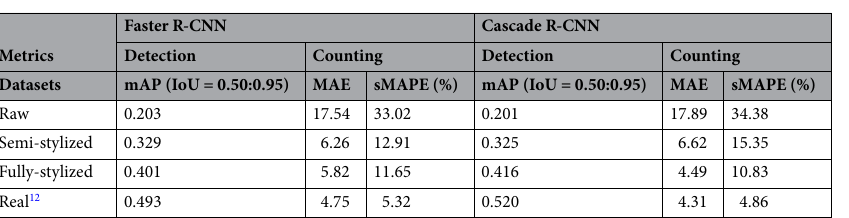
Table 2. Microbial colonies detection tested on real data for three different synthetic training datasets: raw , semi-stylized , and fully-stylized . For comparison, we also provide results for training on the real dataset 12 . We present results for Faster R-CNN and Cascade R-CNN detectors along with various metrics describing detection (mAP), and counting fidelity (MAE,